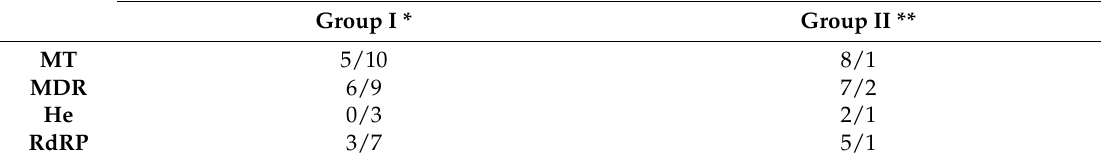
Table 5. Number of CSDaV sequences from symptomatic and asymptomatic plants between the two main phylogenetic groups assessed in this study.